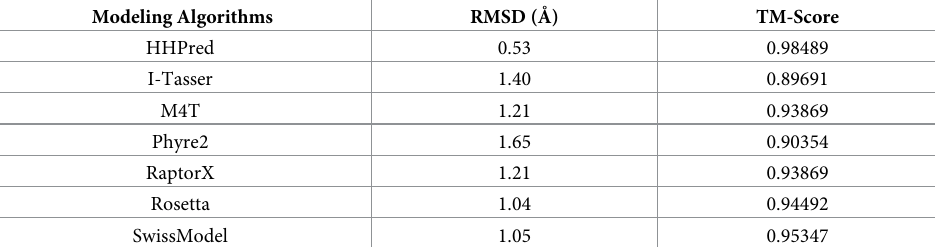
Table 1. Structural alignment of the generated models of BDNF and the 1BND fragment. Modeling